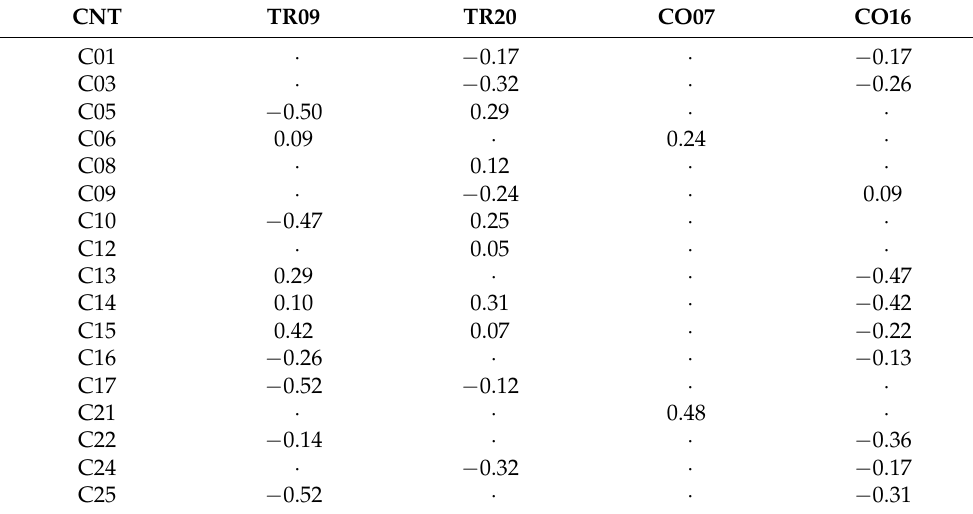
Table 5. Empirical example: Estimated country-specific item intercepts for regularized maximum likelihood estimation based on BIC regularization parameter selection.